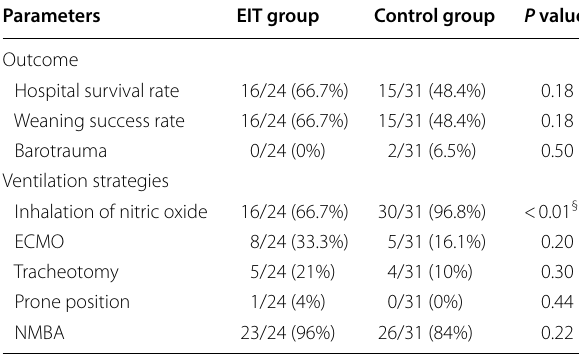
Table 3 Other outcomes and ventilation strategies comparison between two groups